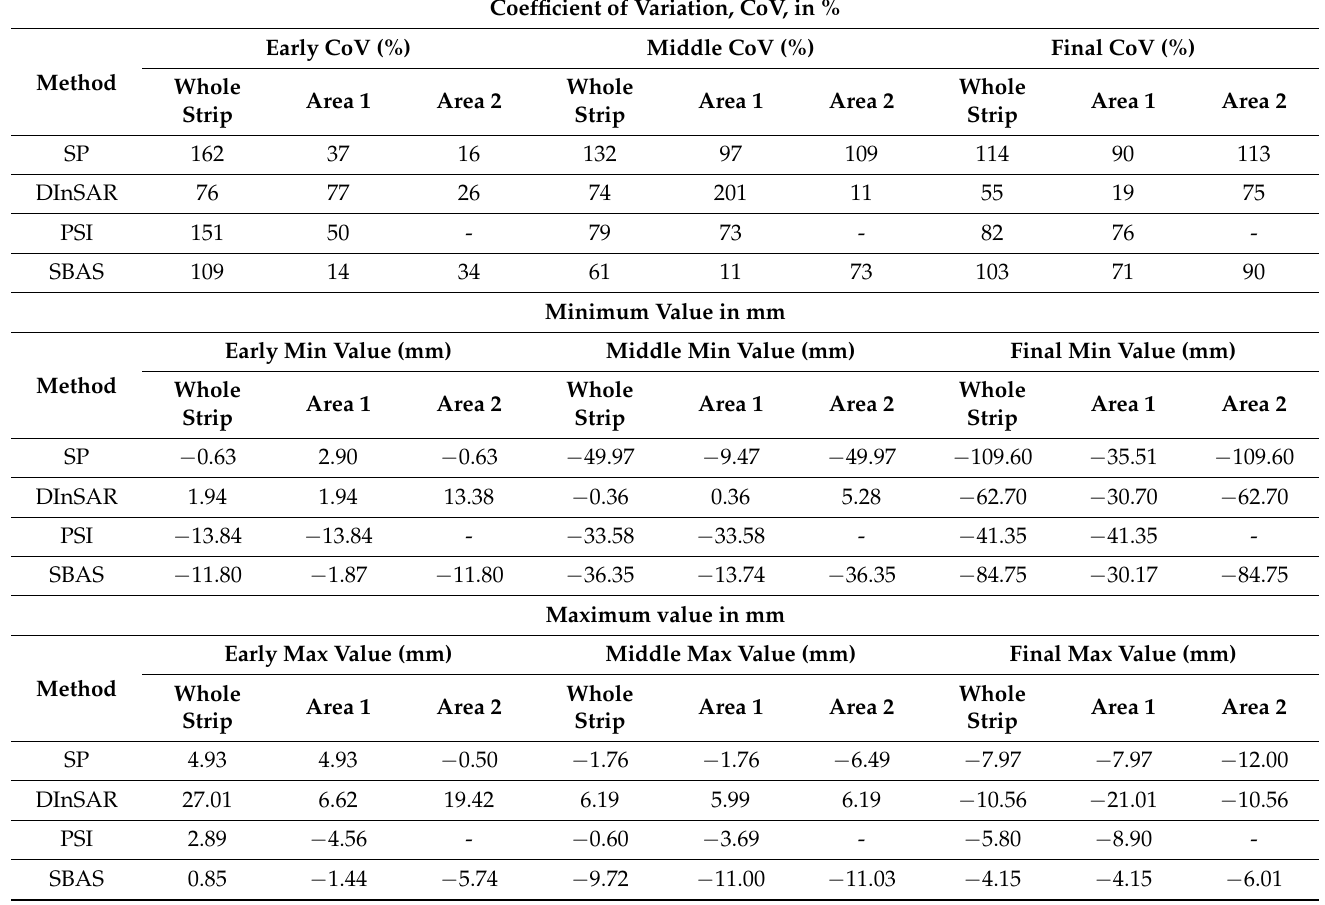
Table 4. Spatiotemporal comparison between SP measurements and InSAR estimates in the